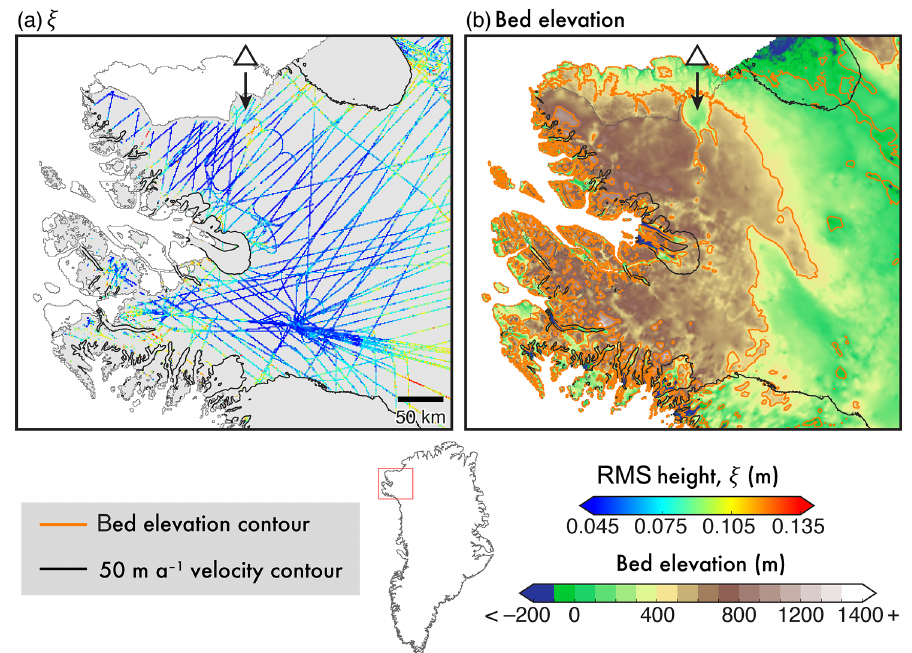
Figure 11. Geological interpretation using scatting-derived roughness, ξ , near Camp Century. (a) ξ , with values in fast-flowing regions (delineated by black contour; | v | > 50ma − 1 ) masked. (b) Bed elevation (BedMachine, v3; Morlighem et al., 2017) with contours at 400m intervals. The site of the Hiawatha impact crater (Kjær et al., 2018), associated with channelised features is marked (triangle; discussed in Sect. 4.3). Location inset.